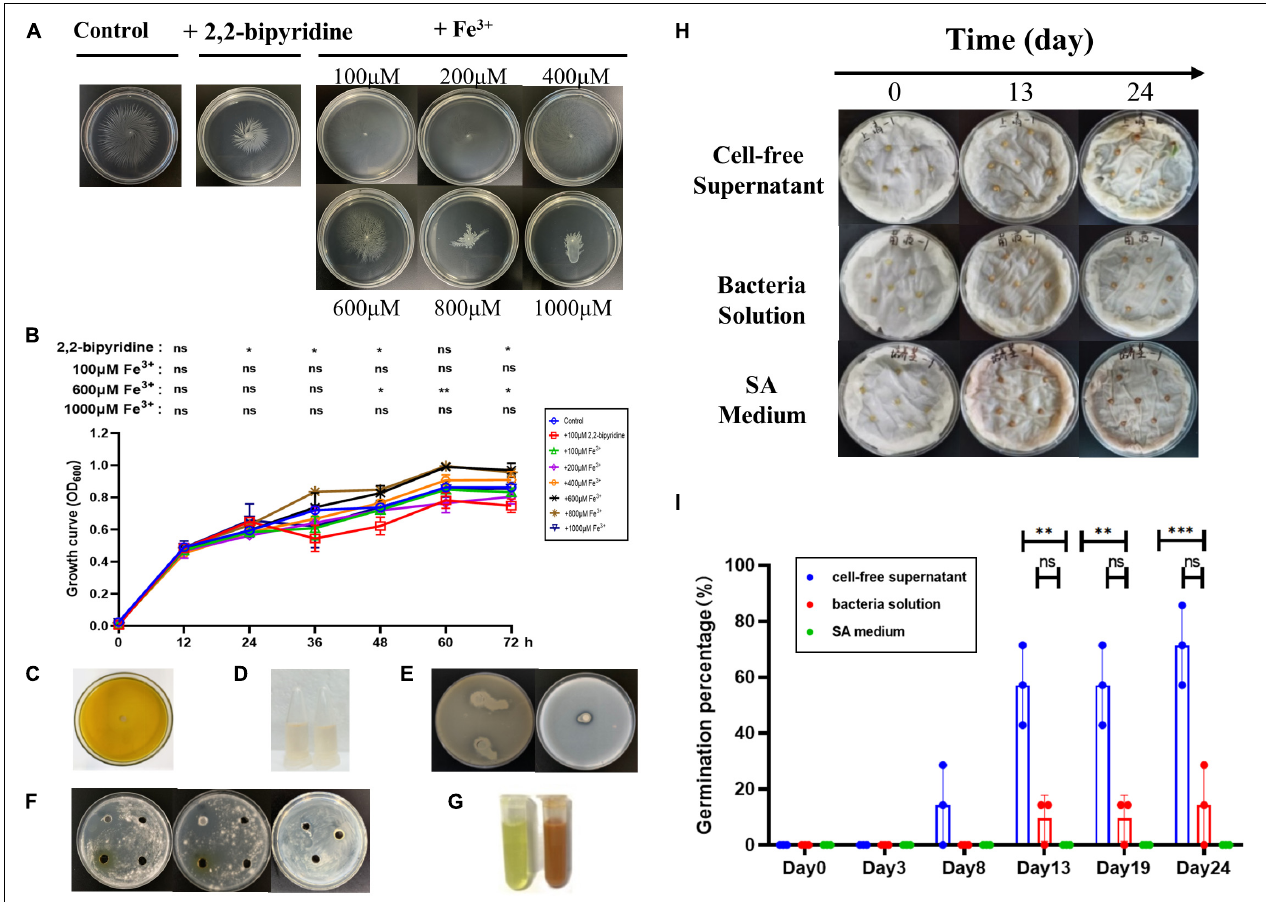
FIGURE 6 | Swimming motility, growth-promoting and seed-germination assays. (A) The swimming of AS19 in solid LB medium with 0.3% agar under different concentrations of Fe 3 + . (B) Effect of different concentrations of Fe 3 + on the growth of AS19. (C) Production of organic acids. (D) Production of IAA. (E) Decomposition of phosphate. (F) Antagonism experiment. (G) Production of ammonia. (H) The germination of pepper seeds treated with CFS and bacterial solution of AS19. The SA medium group was the control group. (I) The germination percentage of pepper seeds (a total of seven in each group). The experiment was repeated three times. Three dots represent the germination percentage of three experiments (ns, no significant difference, ∗ p < 0.05, ∗∗ p < 0.01, ∗∗∗ p <